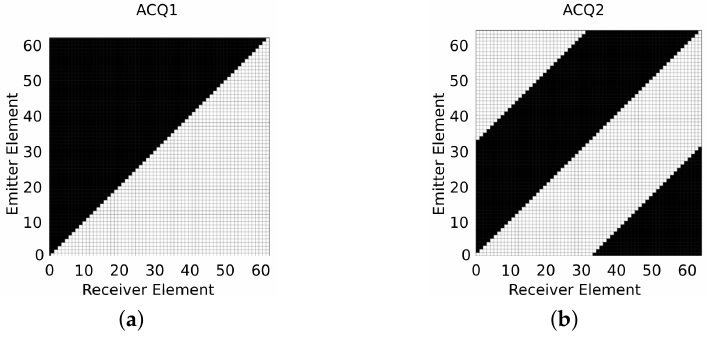
Figure 2. Matrix representation of acquisition strategy ( ACQ ) for a generic array composed by 64 elements. White cells are the active channels. ( a ) ACQ 1—the reciprocity principle has been applied to reduce the number of signals. ( b ) ACQ 2—further optimisation of the electronic resources. Using an array with 64 elements involves 64 × 64 = 4096 signals in the FMC . By ex- cluding the pulse-echo signals, there are 4096 − 64 = 4032 signals, and using the reciprocity principle, s ij = s ji , and only 4032/2 = 2016 signals are needed for the different emit- ter/receiver pairs. Summing the 64 pulse-echo signals, results in 2080 signals. In Figure